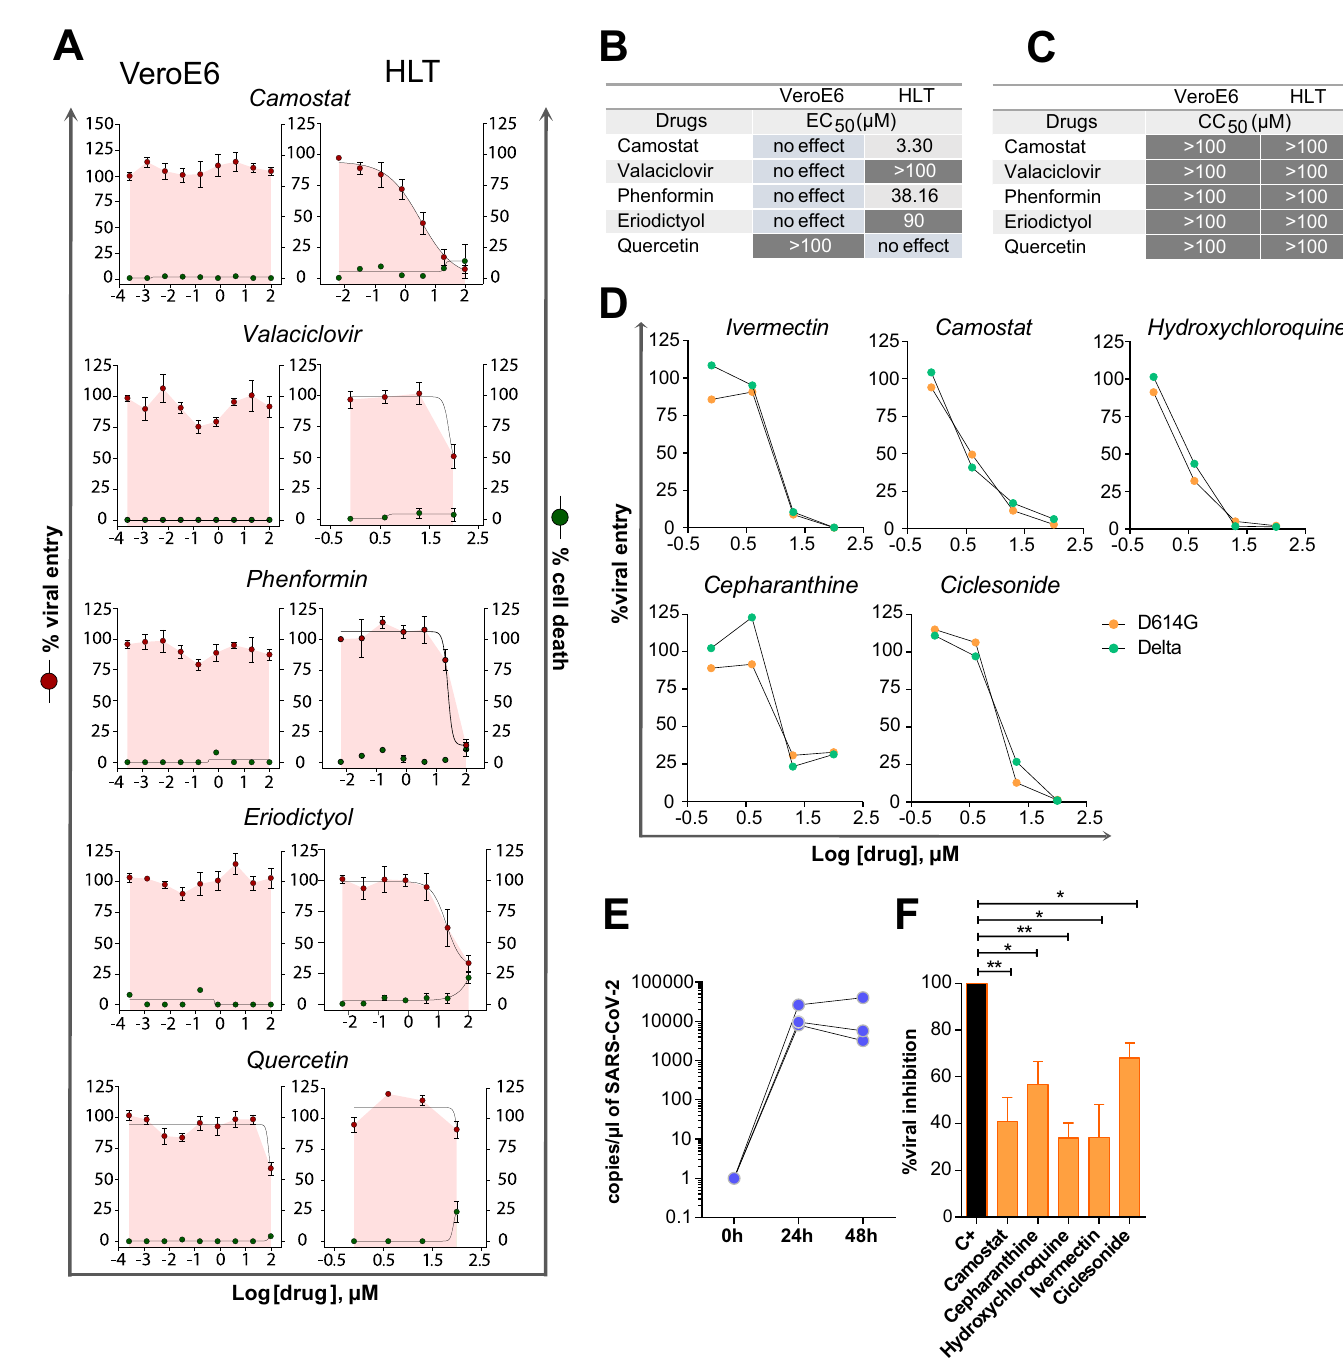
Fig 4. Antiviral assays with discordant results between models. ( A ). Percentage of viral entry in VeroE6 and HLT cells exposed to VSV � Δ G(Luc)-Spike in the presence of camostat, valaciclovir, phenformin, eriodictyol and quercetin. Drugs were used at concentrations ranging from 100 μ M to 0.256 nM, in VeroE6, and to 0.8 μ M in lung cells. Non-linear fit model with variable response curve from at least three independent experiments in replicates is shown (red lines). Cytotoxic effect on VeroE6 cells and HLT exposed to drug concentrations in the absence of virus is also shown (green lines). ( B ). EC 50 values of each drug in VeroE6 and HLT cells. ( C ). CC 50 values of each drug are shown for VeroE6 and HLT cells. ( D ). Percentage of viral entry in HLT cells exposed to VSV � Δ G(Luc)-Spike-delta and VSV � Δ G(Luc)- Spike-D614G variants in the presence of ivermectin, camostat, hydroxychloroquine, cepharanthine and ciclesonide. Drugs were used at concentrations ranging from 100 μ M to 0.8 μ M. ( E ) Number of viral genomes/ μ l at 24h and 48h after infection with replication-competent SARS-CoV-2. ( F ). Percentage of viral replication in the presence of 20 μ M of camostat, cepharanthine, hydroxychloroquine, ivermectin and ciclesonide after infection with replication-competent SARS-CoV-2. Mean ± SEM is shown. Data in panel 4F were analyzed by one sample t-test; � p < 0.05, �� p < 0.01.